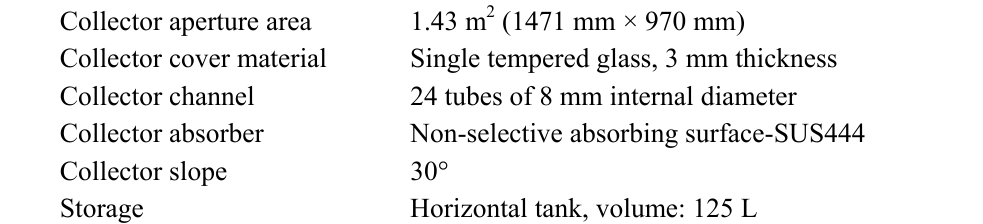
Table 1. Main technical characteristics of the direct-heating solar water heater.